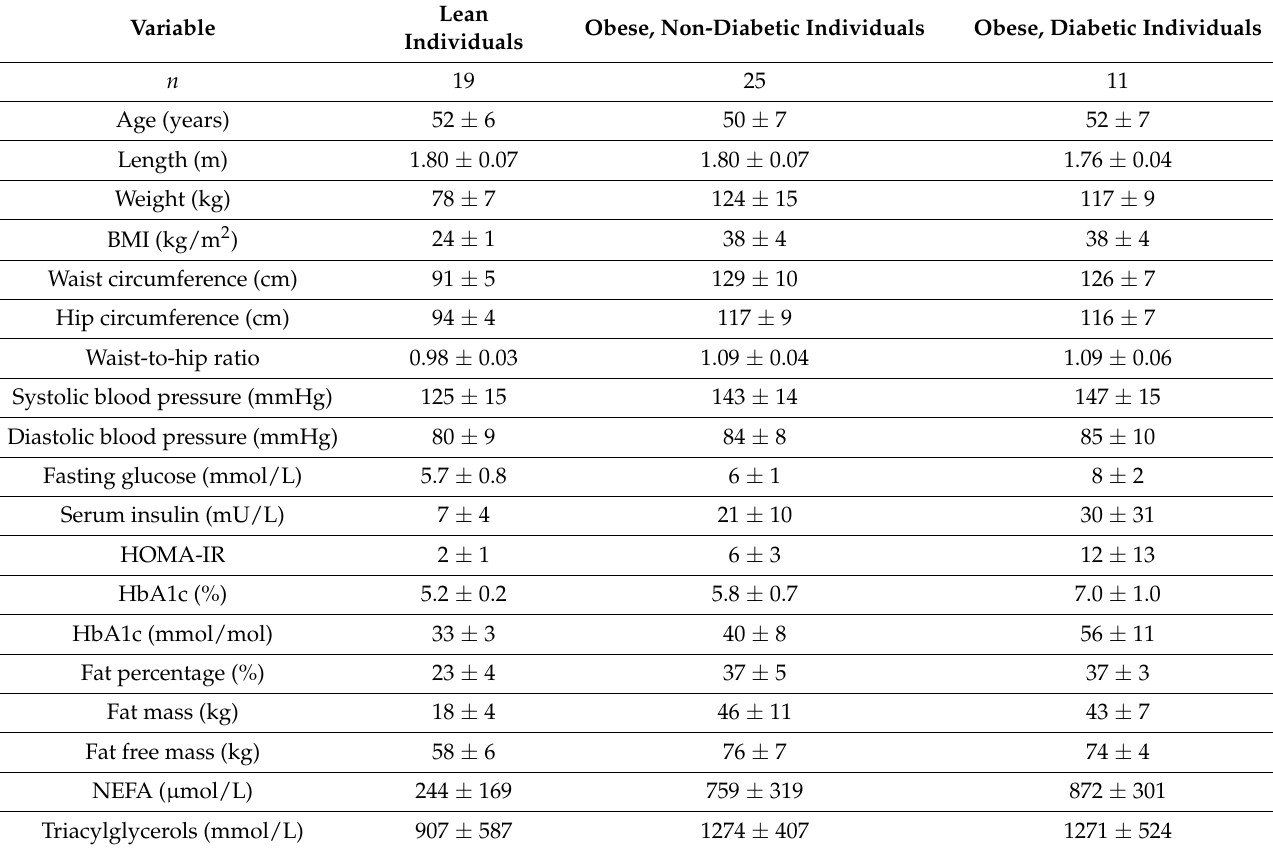
Table 1. Characteristics of lean, obese non-diabetic and obese diabetic men. Data are expressed as mean ±